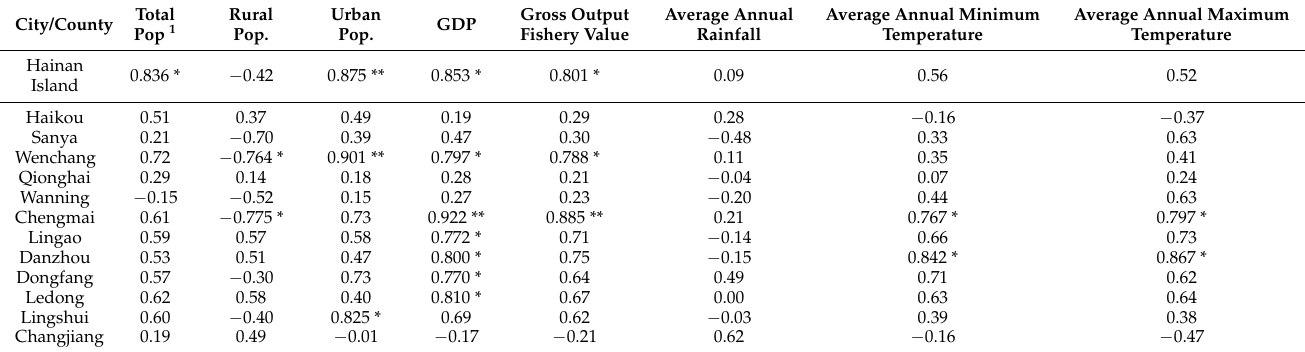
Table 7. Pearson correlation analysis results of mangrove forest crown surface cover area with socioeconomic and climatic factors over the Hainan Island during